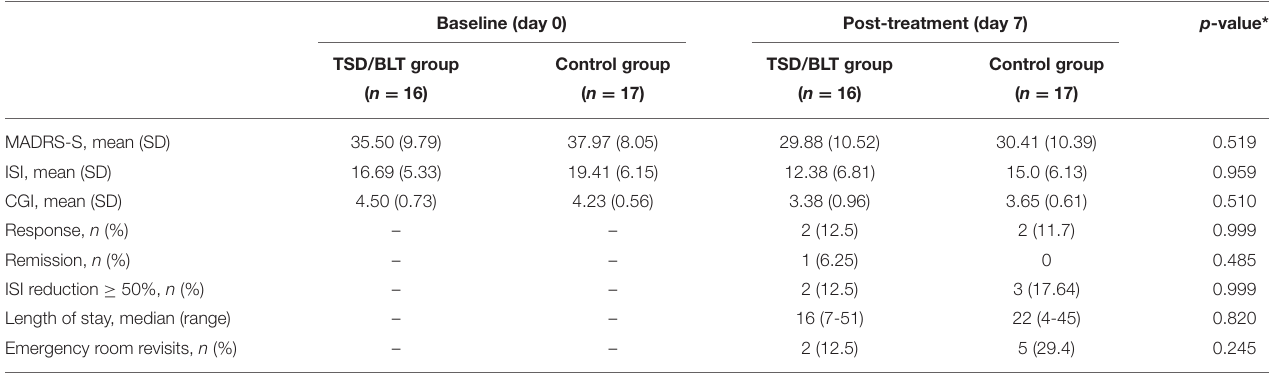
TABLE 4 | Major outcomes on intention-to-treat analysis.